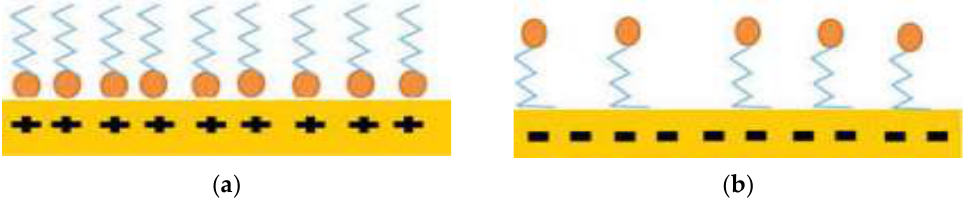
Figure 1. Schematic diagram of the electrostatic interaction between ( a ) surfactant headgroup and positive-charged sites in shale, and ( b ) surfactant weak tail and negative-charged sites in shale. Modified after Zhou et al. [39].